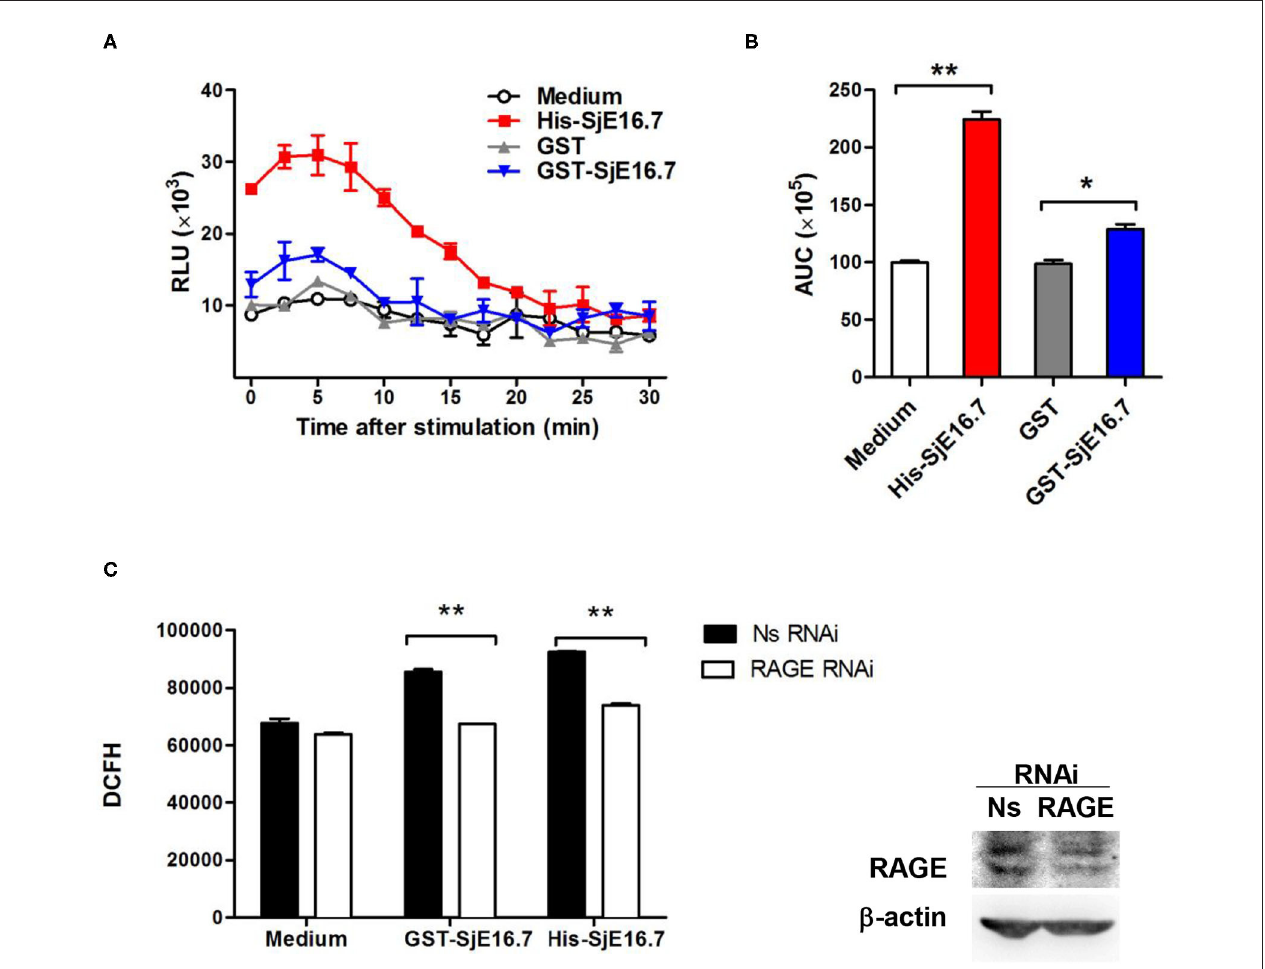
FIGURE 2 | SjE16.7 promotes ROS production via RAGE. (A) BMDMs were stimulated with 1 µ M eukaryotic recombinant protein His-SjE16.7 or prokaryotic recombinant protein GST-SjE16.7 GST, or GST control. ROS production was measured by chemiluminescence assay as described in section Materials and Methods. Data shown are profiles of the kinetics of ROS production. RLU, relative light unit. (B) Area under curve (AUC) in (A) is shown. (C) The expression of RAGE in RAW 264.7 cells was knocked down by lentivirus-mediated RNA interference (RNAi), and then the effect of SjE16.7 on ROS production was determined by DCFH assay (left panel). RAGE expression levels were measured by Western blot (right panel). Statistical analysis was performed on pooled data from three independent experiments. * p < 0.05, ** p < 0.01 compared with indicated control group.